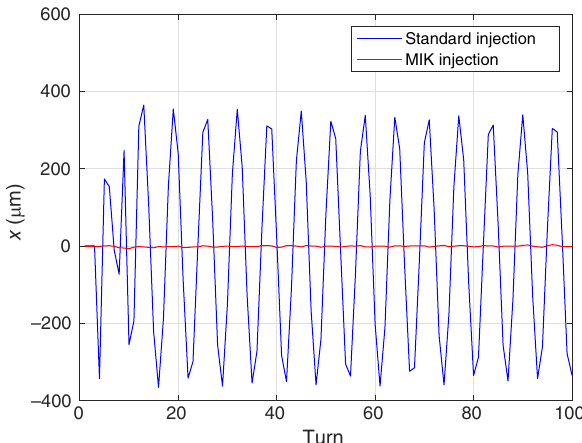
FIG. 11. Residual horizontal betatron oscillations due to the four kickers(blue)andtheMIK(red).Measurementswith β x ¼ 13 . 3 m.